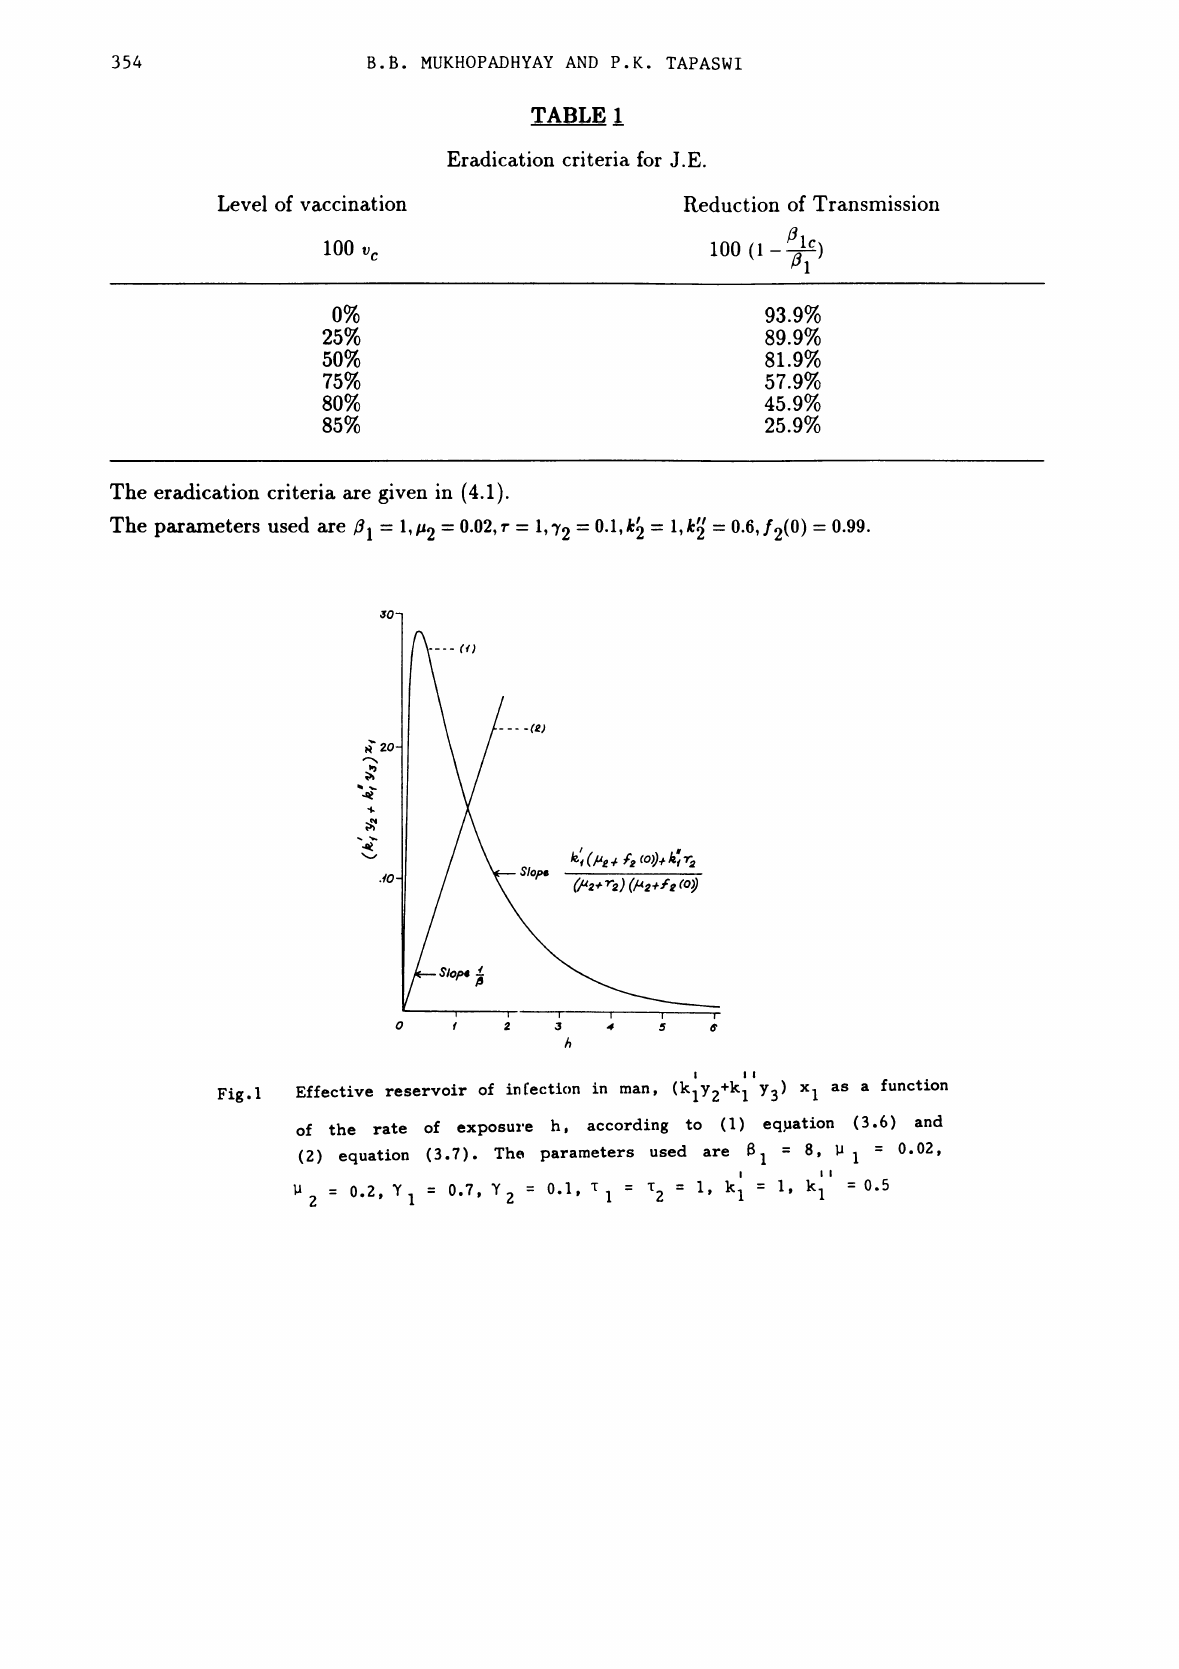
Eradication criteria for J.E.